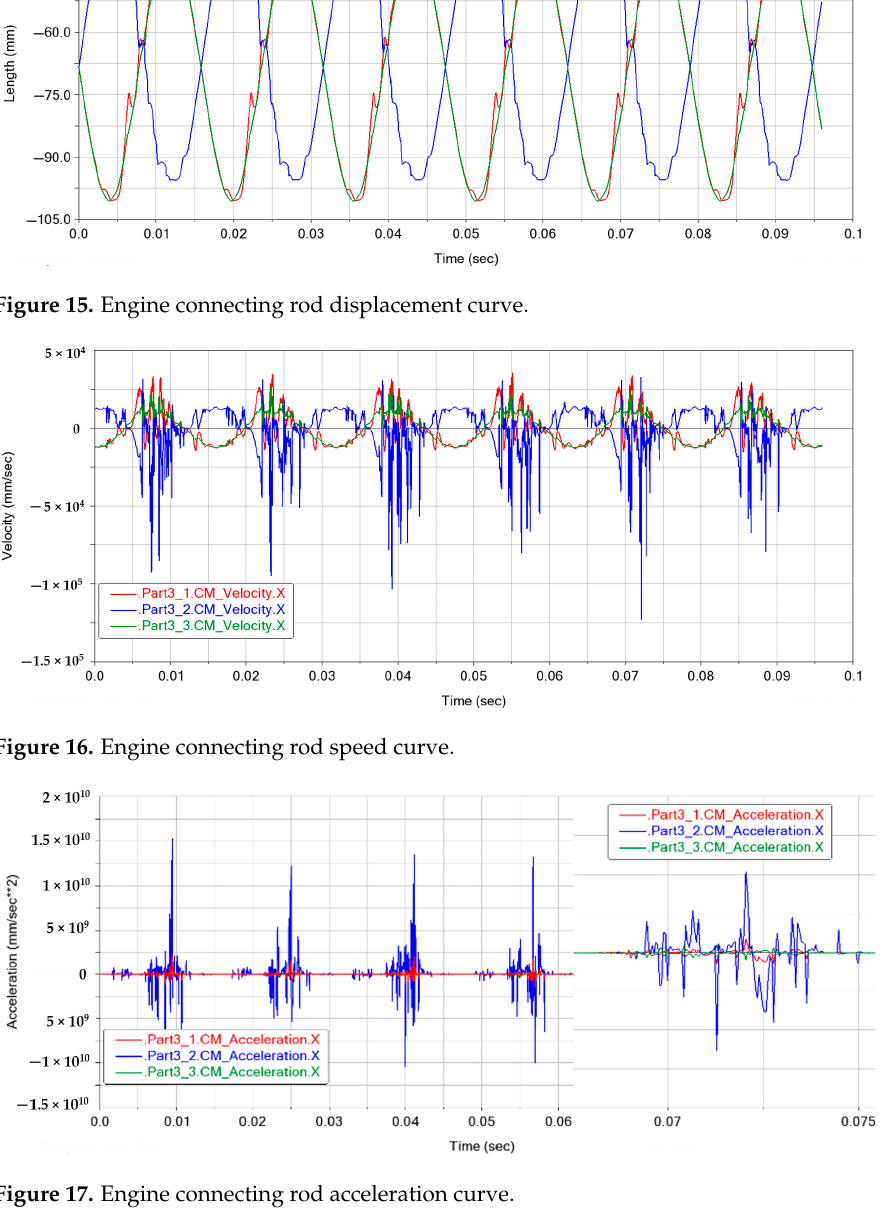
Figure 17. Engine connecting rod acceleration curve.